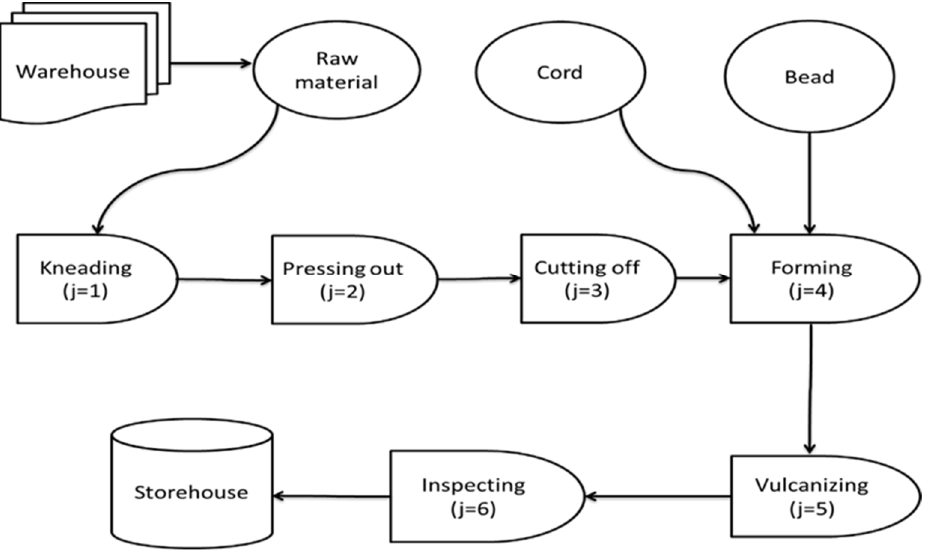
Figure 1. Tire manufacturing flow chart.